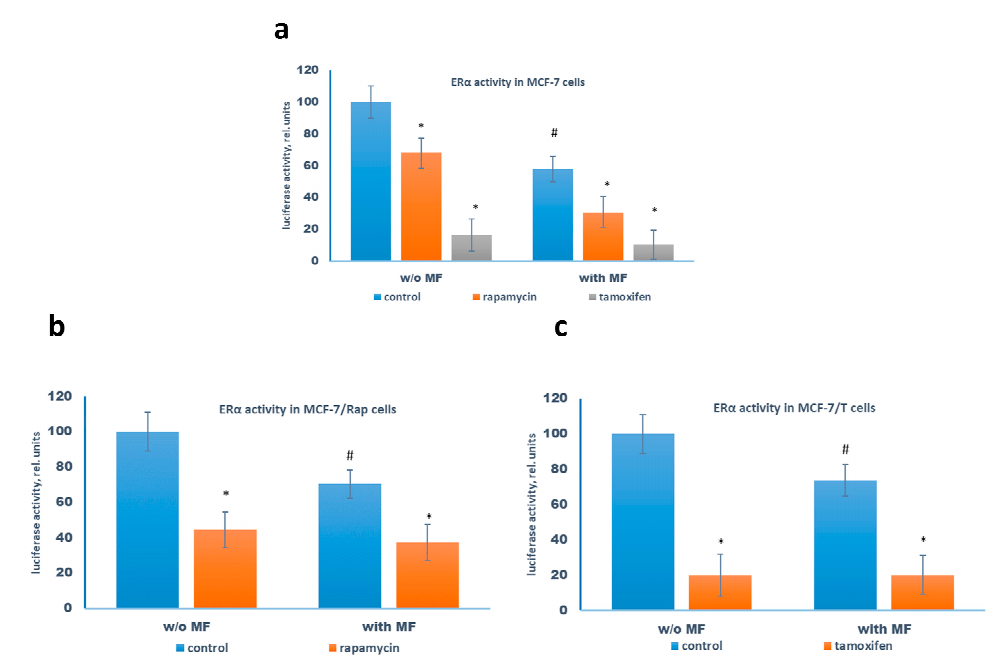
Figure 5. Reporter analysis of the transcriptional activity of the estrogen receptor. The MCF-7 ( a ), MCF-7/Rap ( b ), and MCF-7/T ( c ) cells were pretreated with or without 2 mM metformin (MF) for 2 days, then the cells were transfected with the ERE plasmid containing the luciferase reporter gene under the estrogen-responsive element (ERE) and β -galactosidase plasmid. After 3 h the cells were treated for 24 h with the combination of tested drugs as indicated at the diagram. The luciferase and β -galactosidase activities were determined as described in Materials and Methods. Data represent the mean value ± SD of three independent experiments. p < 0.05: * versus respective control, # versus control cells w/o metformin.